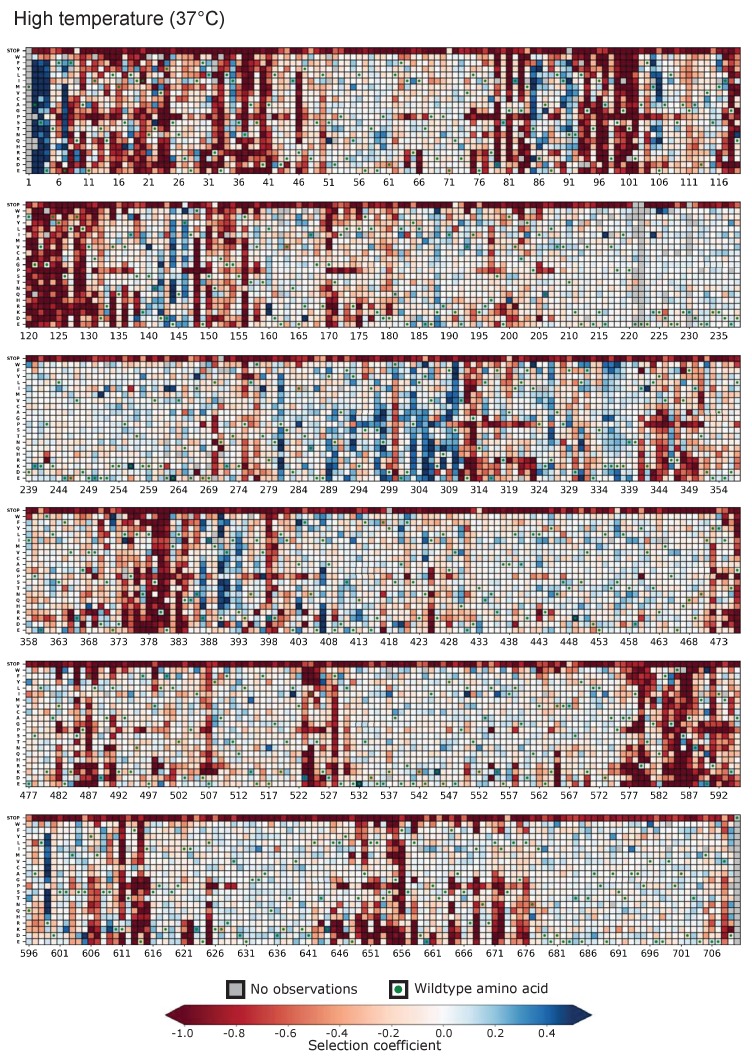
Heatmap representation of the fitness map observed for single amino acid changes of Hsp90 at 37°C.